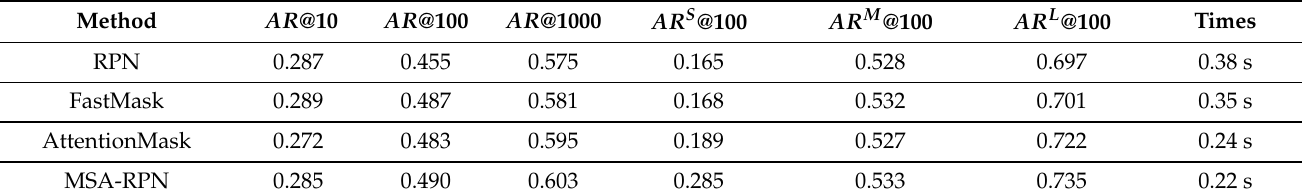
Table 4. Average recall rates of MSA-RPN and the other State-of-the-Art methods on the LEVIR